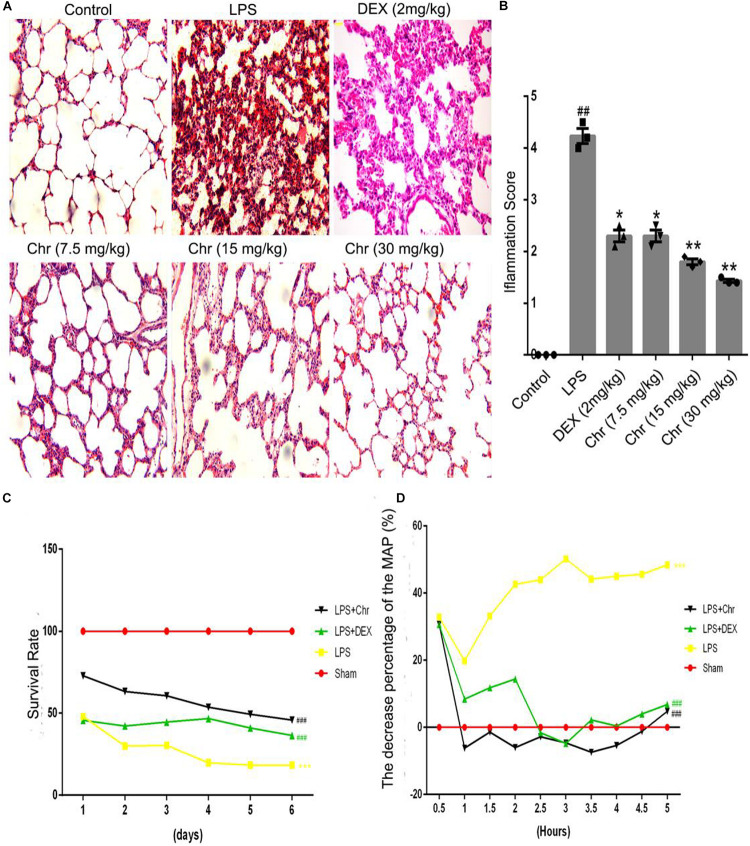
Effects of Chr on the pathological changes, survival rate, and MAP of ALI mice (n = 12). (A,B) Pathological effects of Chr (7.5, 15, 30 mg/kg) in lung tissues (×200). (C) Survival rate of different groups. (D) MAP was recorded over 5 h at 30 min intervals. #P < 0.01, ##P < 0.01, ###P < 0.001 vs. control group; *P < 0.05, **P < 0.01, ***P < 0.001 vs. LPS group.